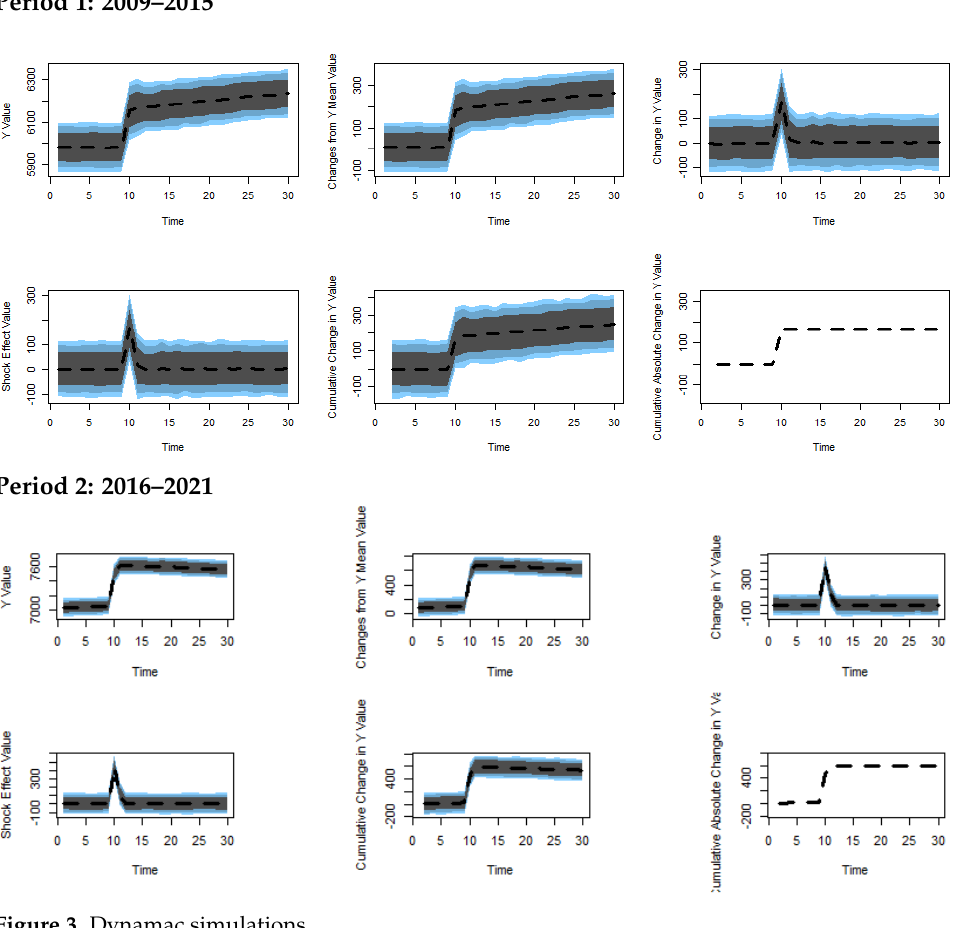
Figure 3. Dynamac simulations. Table 5. Tests of weak-form